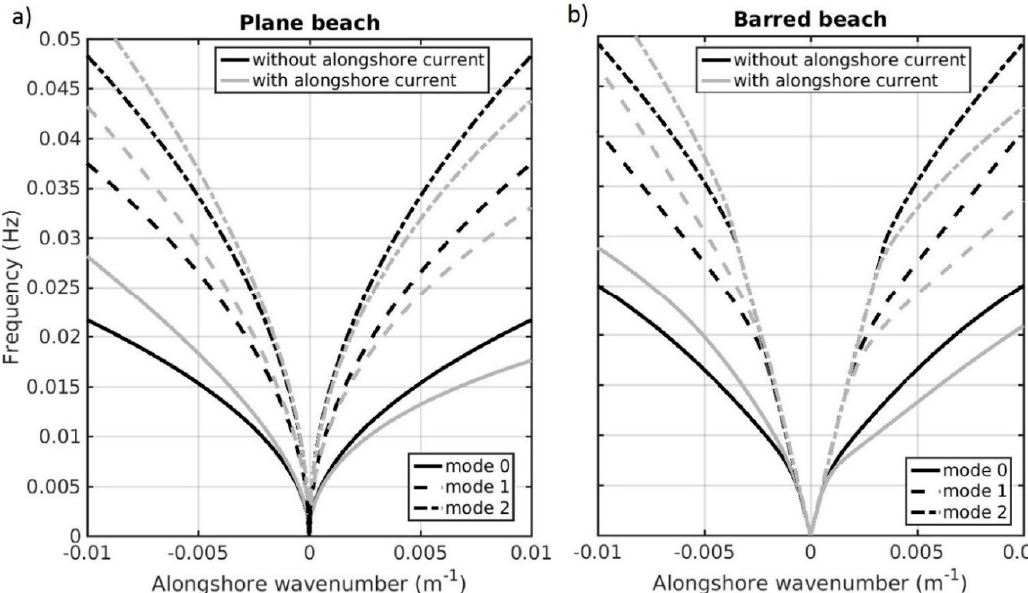
Figure 1. Edge wave dispersion curves for a) a plane beach, β = 0.03, b) Secret Harbour beach averaged cross-shore profile (barred beach), without alongshore current (black) and with alongshore current (as measured during sea breeze periods) (gray) for the three first modes. Positive (negative) wavenumbers represent edge wave progressing southward (northward).